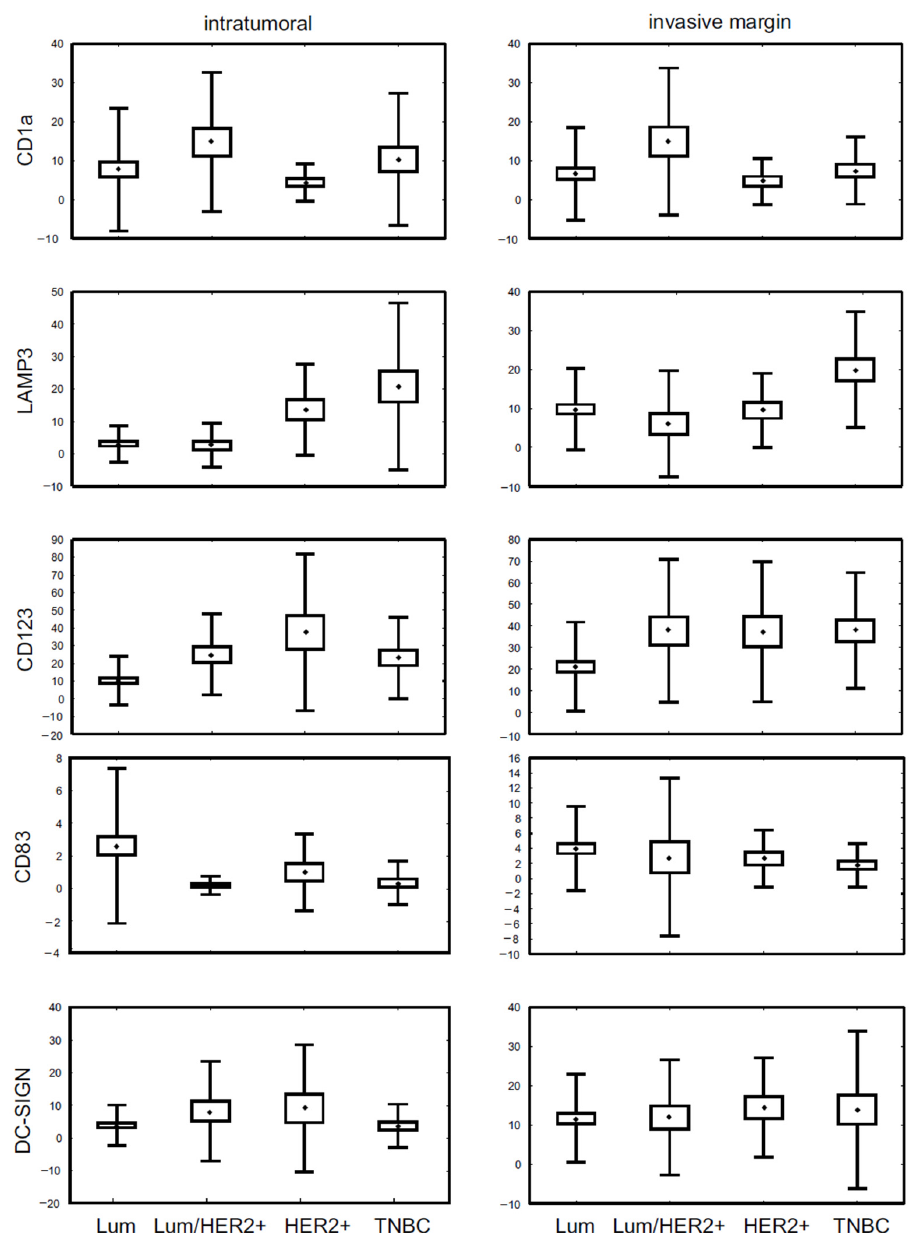
Figure 1. The density of investigated dendritic cell (DC) subpopulations in breast cancer specimens representing different molecular subtypes. Abbreviations used: Lum/HER2+—luminal/HER2+, HER2+—HER2+ non-luminal, TNBC—triple negative subtype. The central point is the arithmetic mean, the box is the arithmetic mean ± standard error and the whisker is the arithmetic mean ± standard deviation.